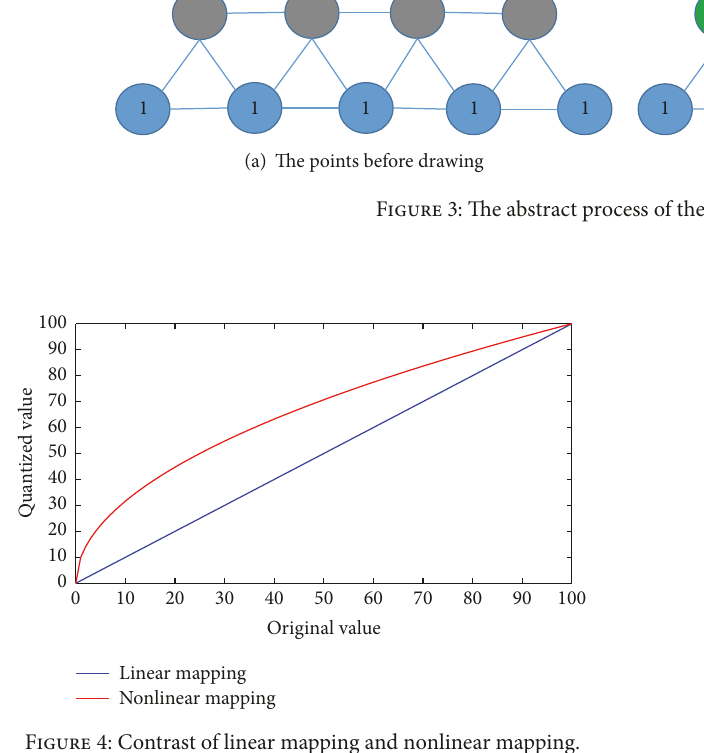
Figure 4: Contrast of linear mapping and nonlinear mapping.